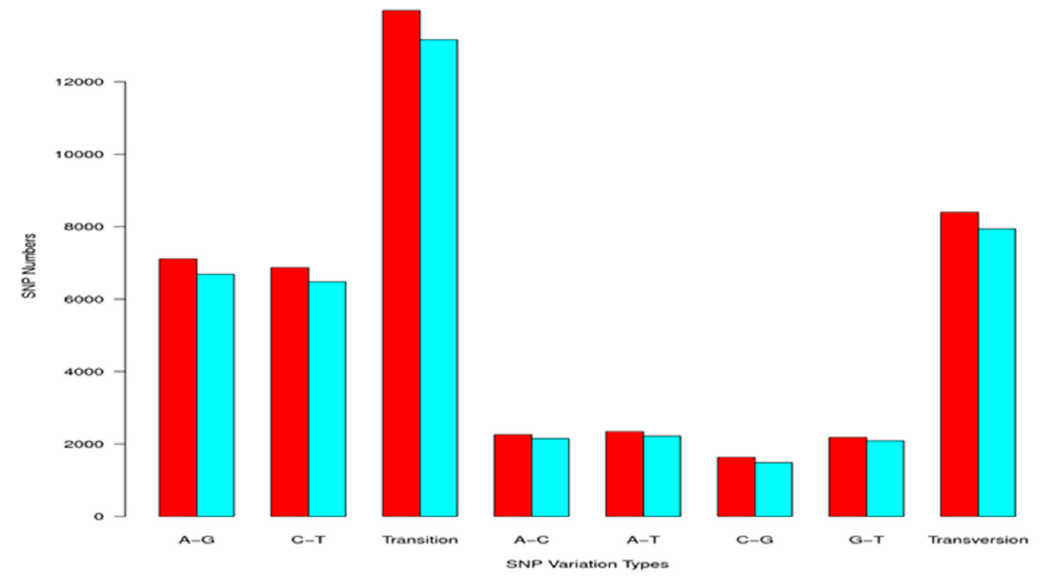
Figure 8. Statistics of Single nucleotide polymorphism (SNP) type in cDNA library from control and bacterial infection. Table 4. Validation of relative expression levels of immune-related genes after A. sorbia infection from RNA-Seq and real-time polymerase chain reaction. Spleen Muscle Gene